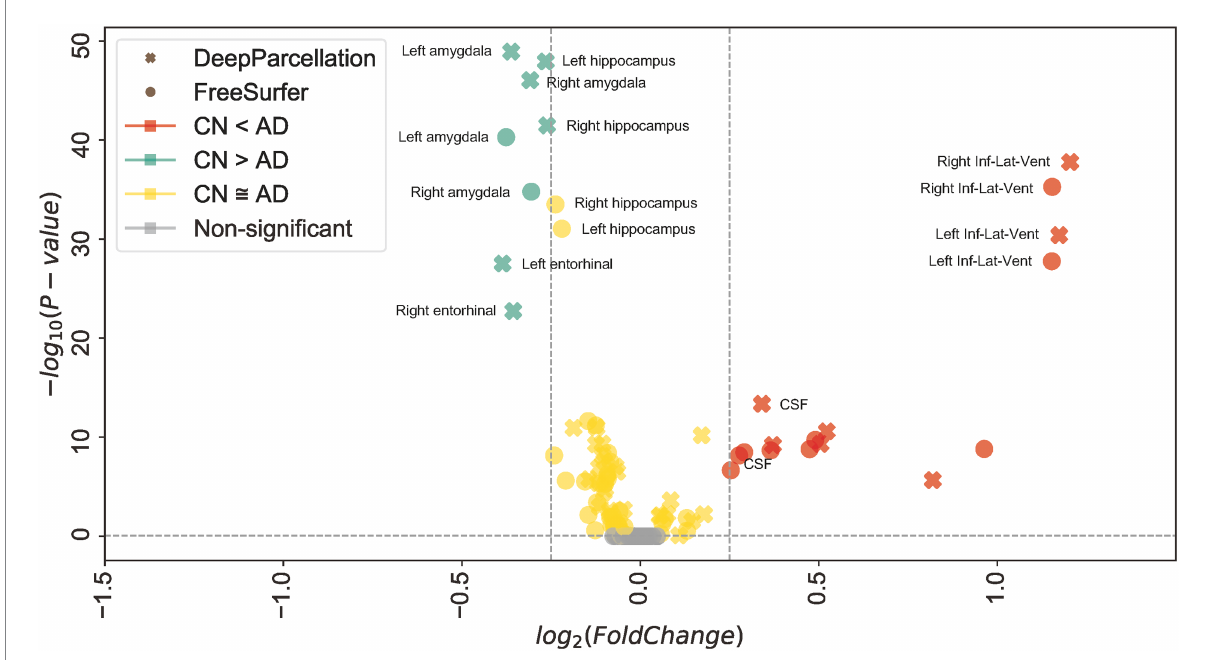
FIGURE 4 Robust dissociation of different diagnosed groups in DeepParcellation. Mean of normalized cortical volume with DeepParcellation (X) and FreeSurfer (O) in selected highly ranked regions sorted by the difference in the negative logarithm of p values between the cognitive normal (CN) and Alzheimer’s disease (AD) groups. DeepParcellation showed higher significance of normalized cortical volume differences than did FreeSurfer in regions highly associated with AD.